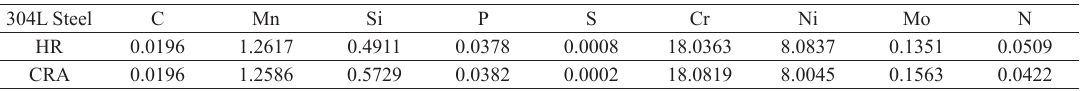
Table 1. Chemical composition of 304L steel (weight %).